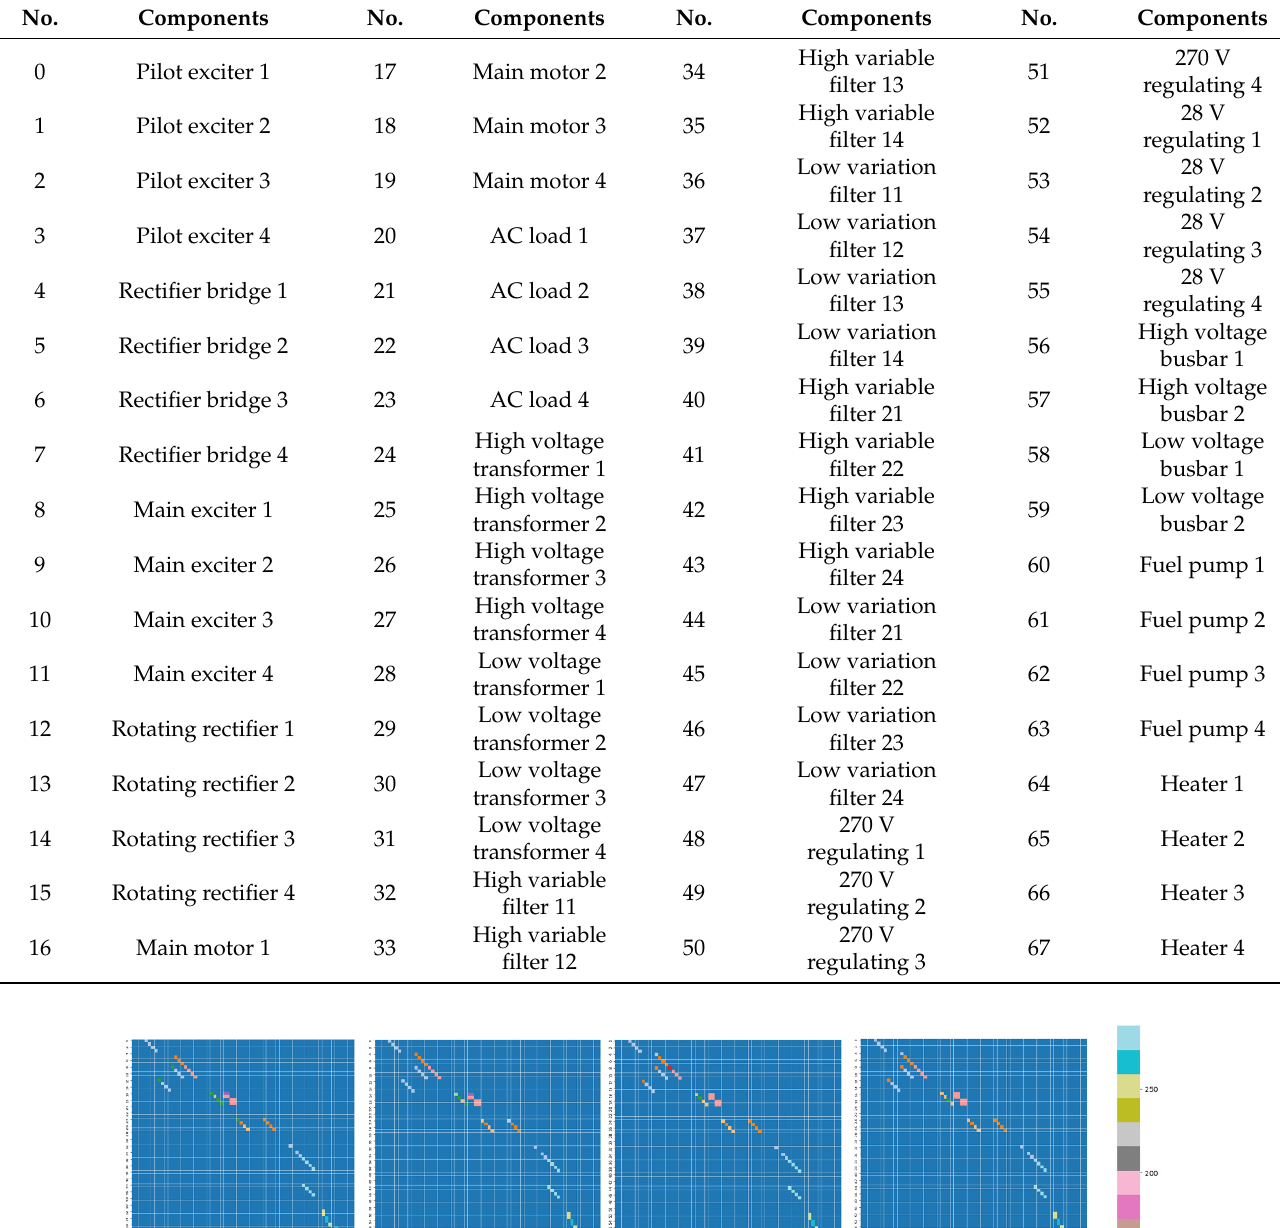
Table 1. Associated mode cluster component serial number name comparison table.